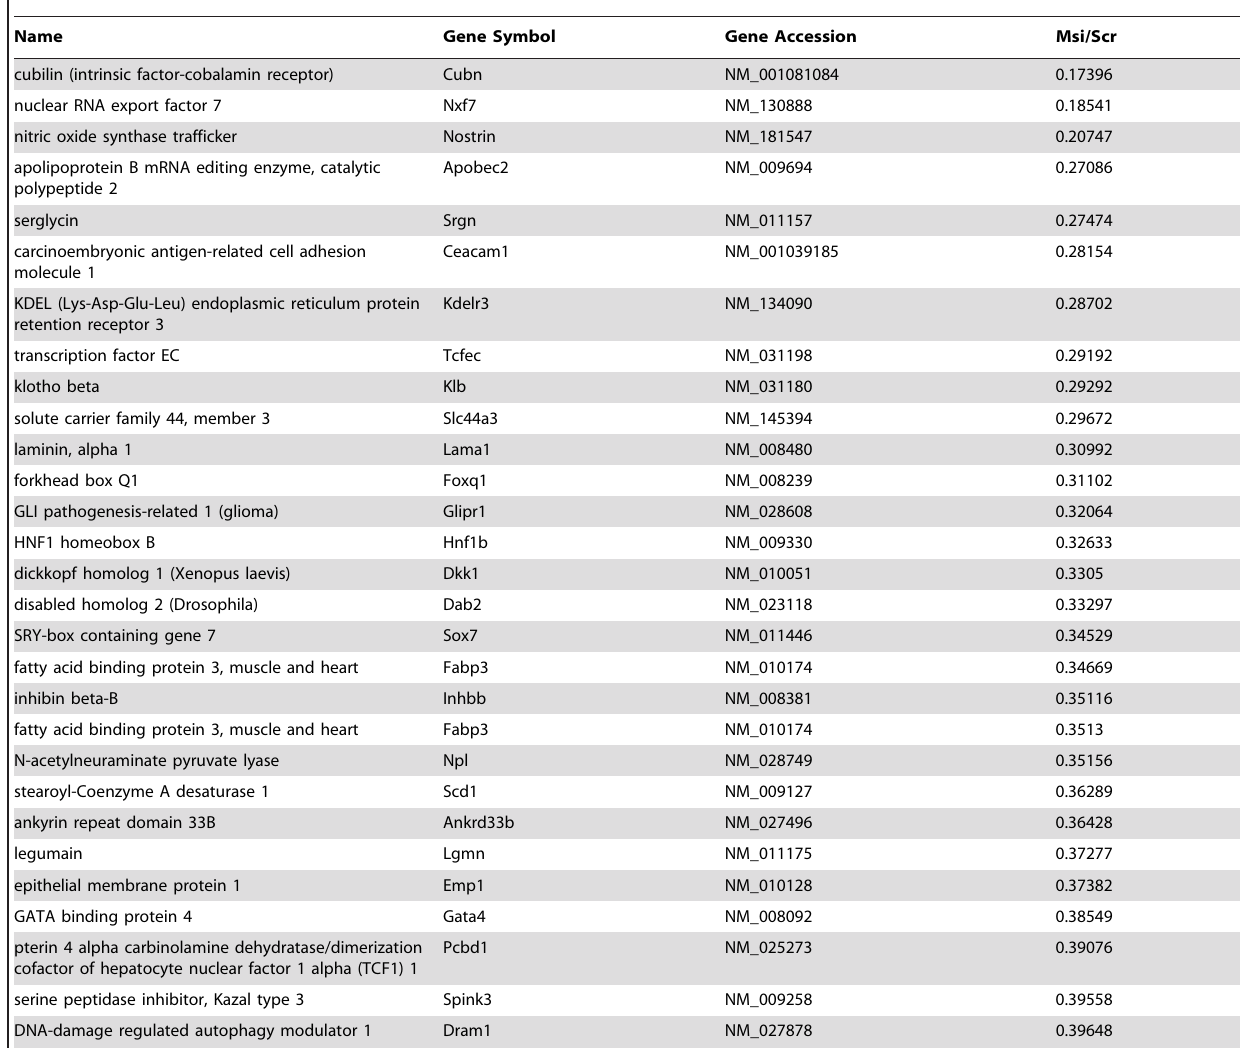
Table 2. Genes more highly expressed ( . 2.5-fold) in control scr-shRNA treated